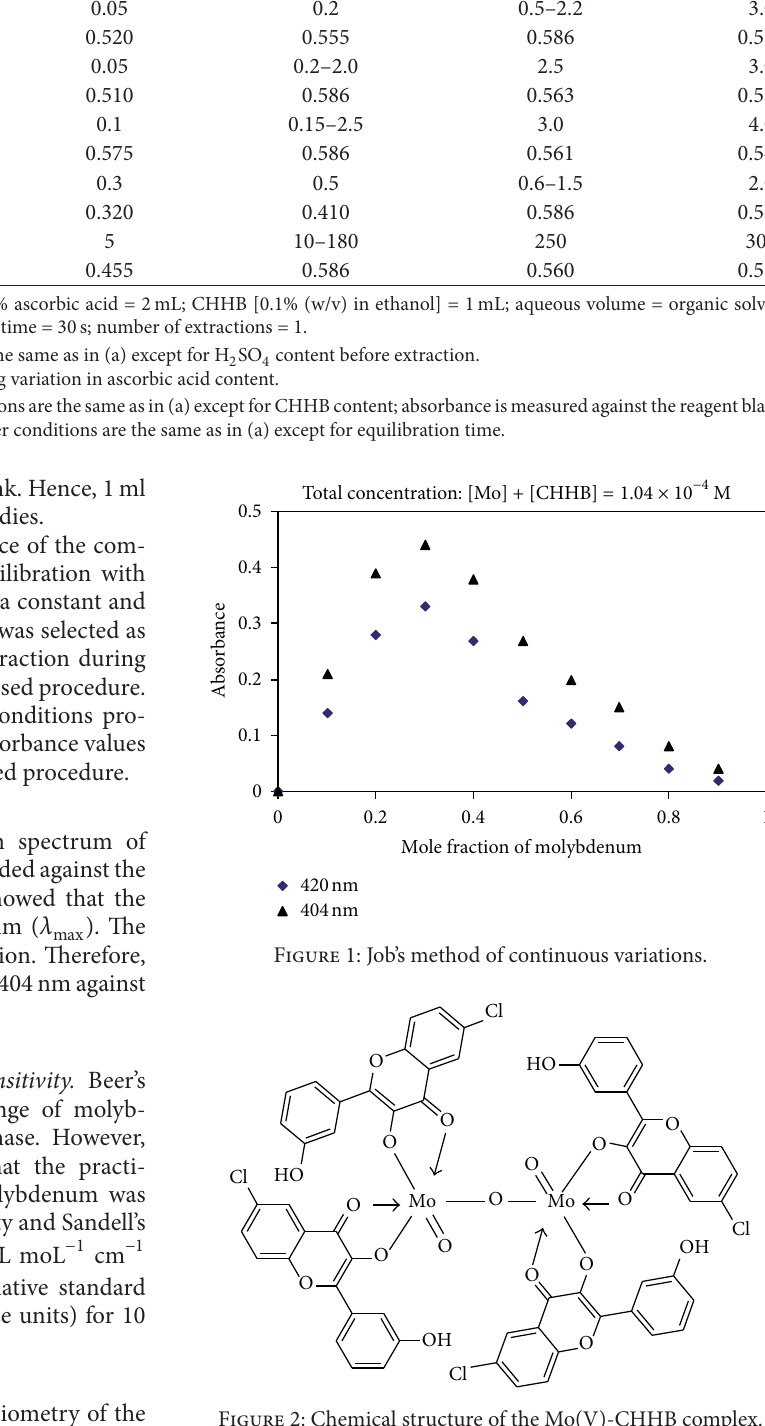
F 2: Chemical structure of the Mo(V)-CHHB